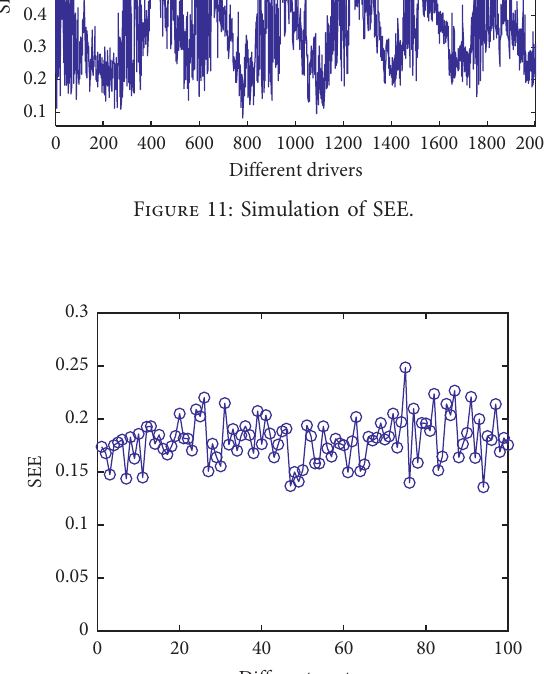
Figure 12: The different routes of SEE.